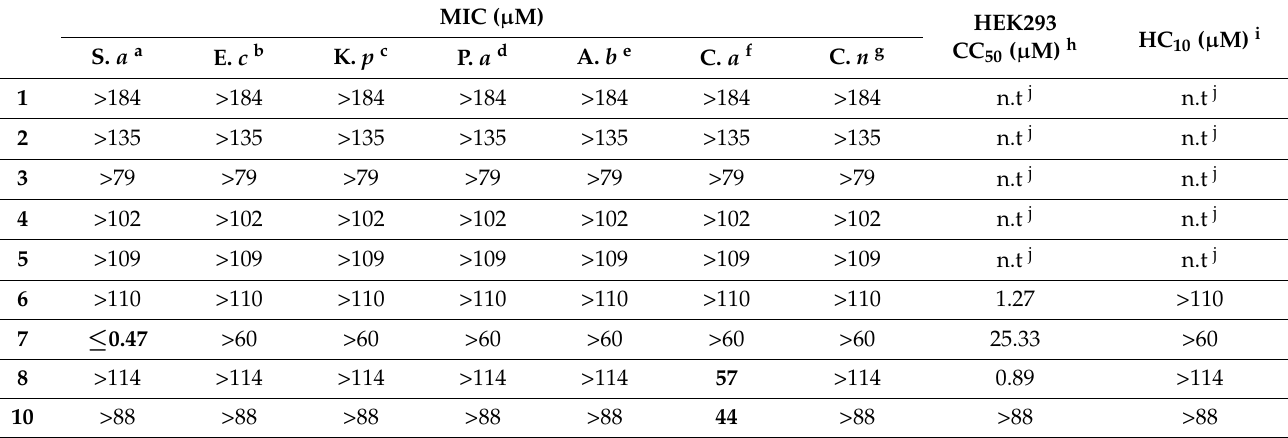
Figure 2. Structures of the isolated natural products 1–10 . Table 1. Antimicrobial and antifungal activities of natural products 1–8 and 10